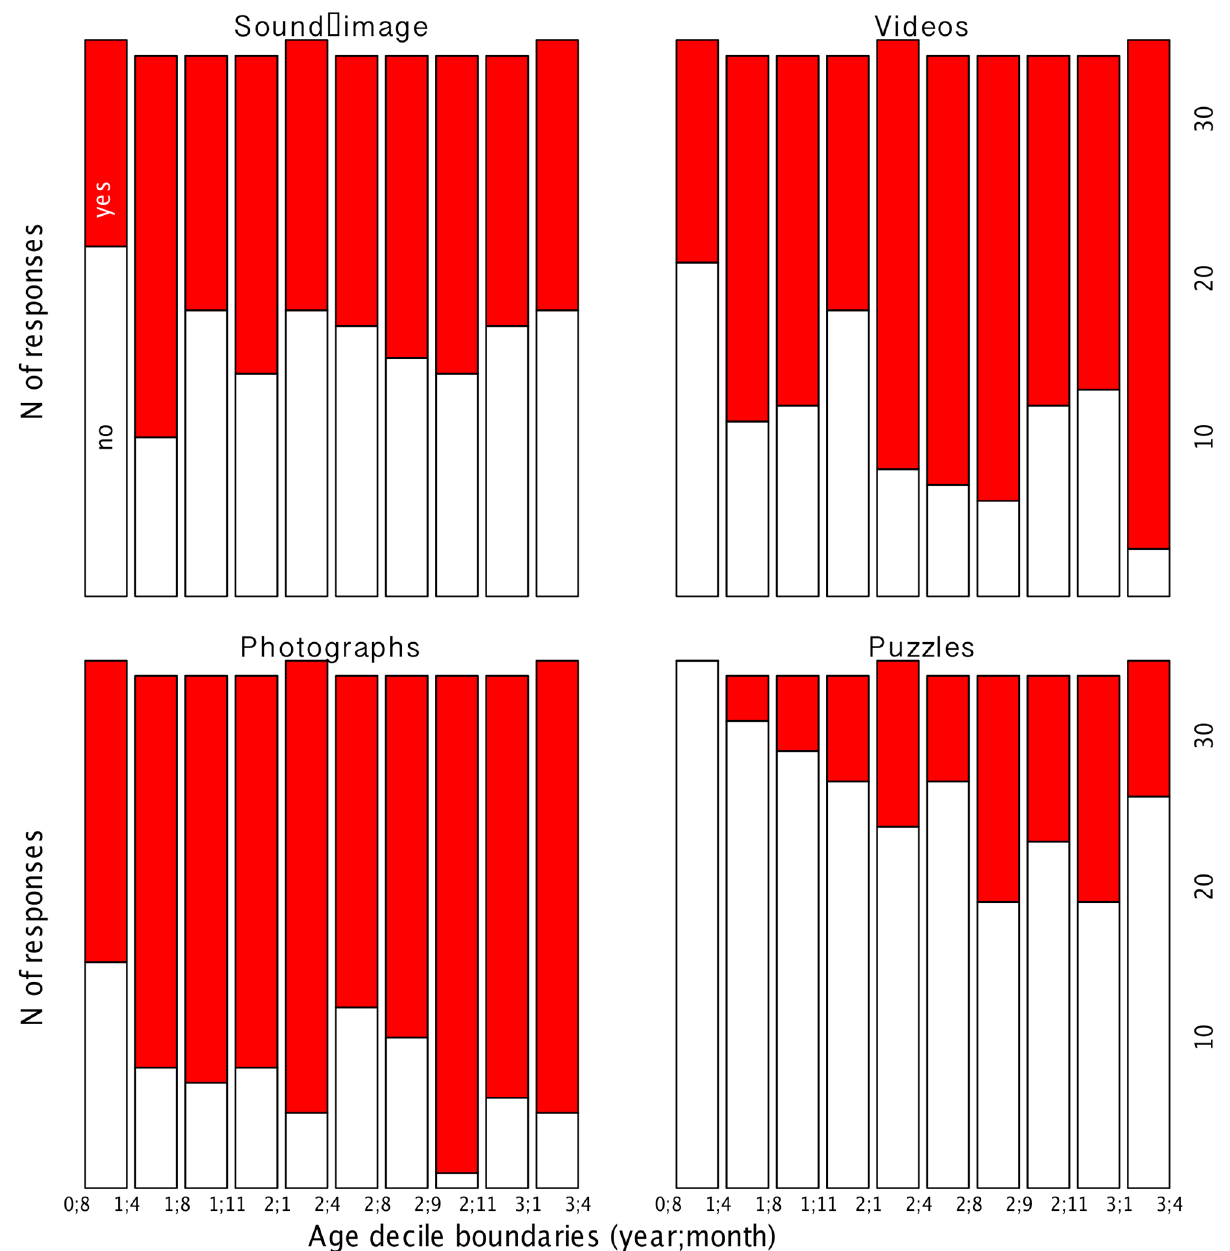
Fig 3. Activity reportedly liked by age decile. Caregivers ’ report of whether their child enjoyed an activity (red) or not (white), grouping children in ten equally-sized age groups. The limits of some of the age groups (in year;month) are given in the x-axis (see Fig 2 for full list).